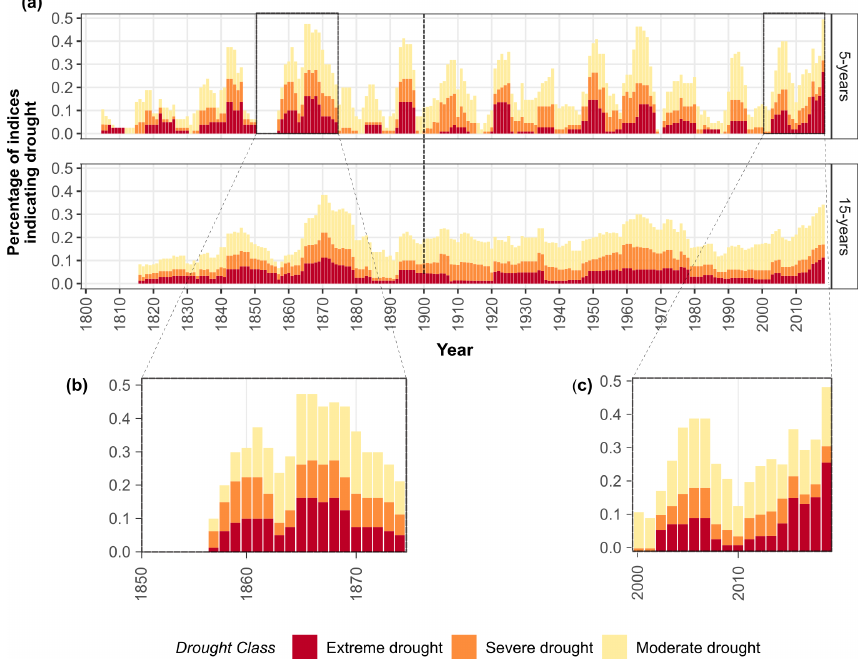
Figure 4. The combined drought index of C 5 and C 15 showing the relative amount of all indices in drought (different severities) smoothed with a 5- and 15-year ( C 5 and C 15, respectively) backward smoothing